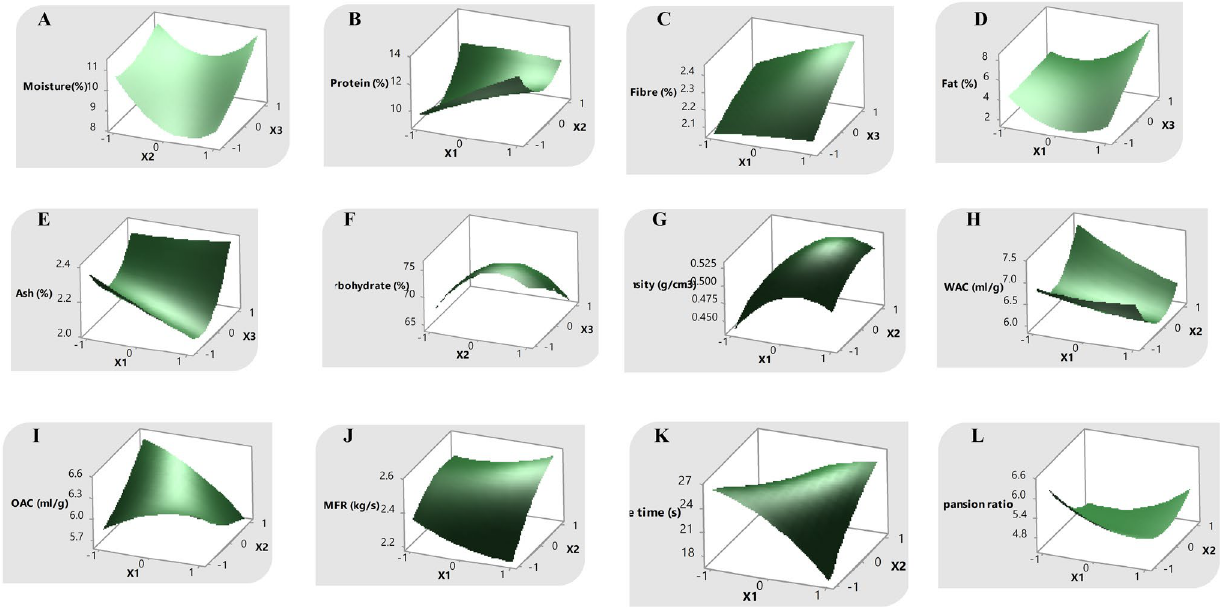
Fig. 1 Surface plots of the responses (proximate composition, extrudates, and functional properties) evaluated. A Moisture B Crude protein C Crude fibre D Crude fat E Ash F Carbohydrate